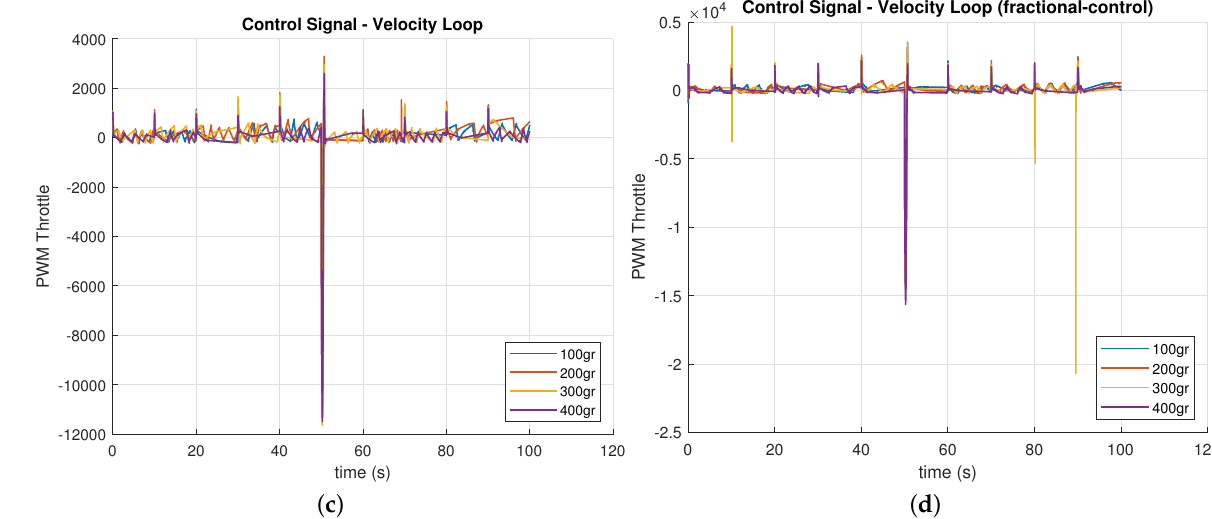
Figure 25. Control signals test results with different payloads. ( a ) Position loop control signals with integer controller. ( b ) Position loop control signals with fractional controller. ( c ) Velocity loop control signals with Integer controller. ( d ) Velocity loop control signals with fractional